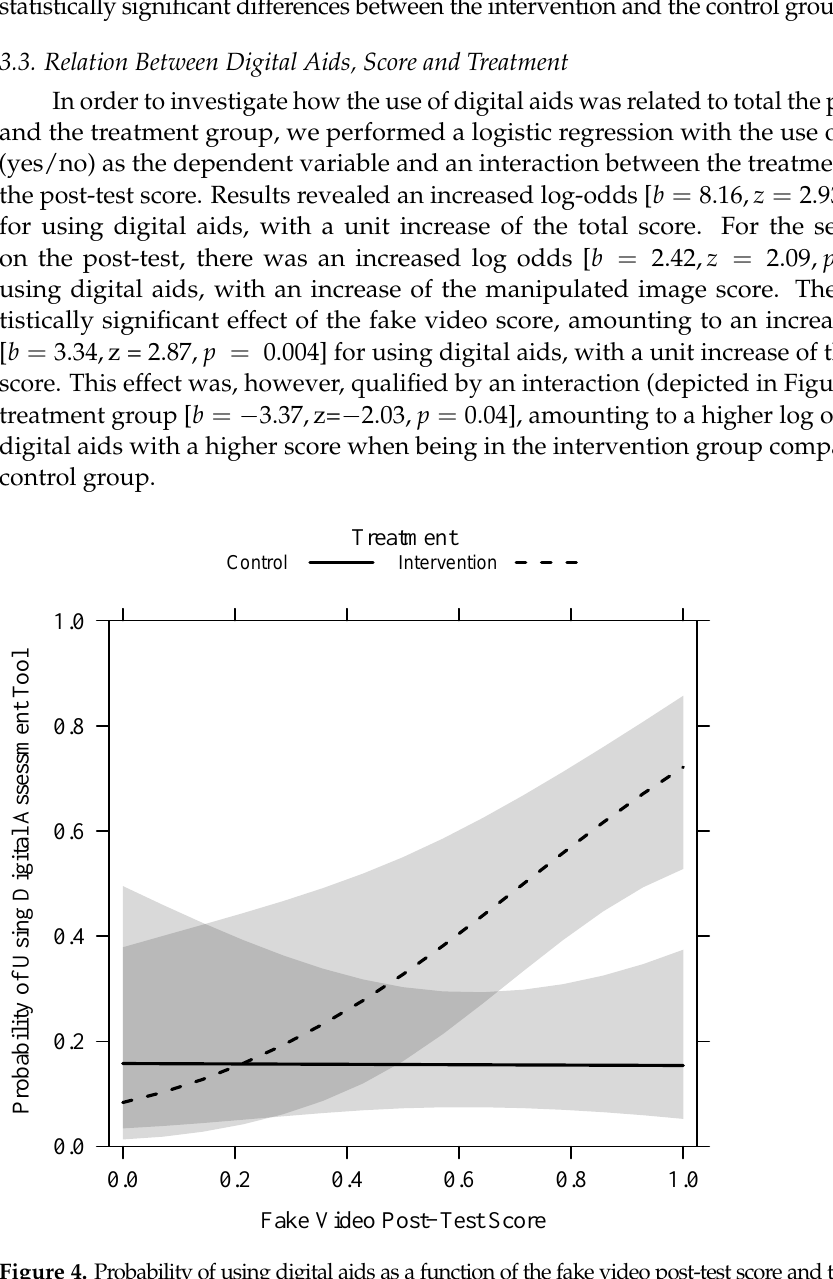
Figure 4. Probability of using digital aids as a function of the fake video post-test score and treatment